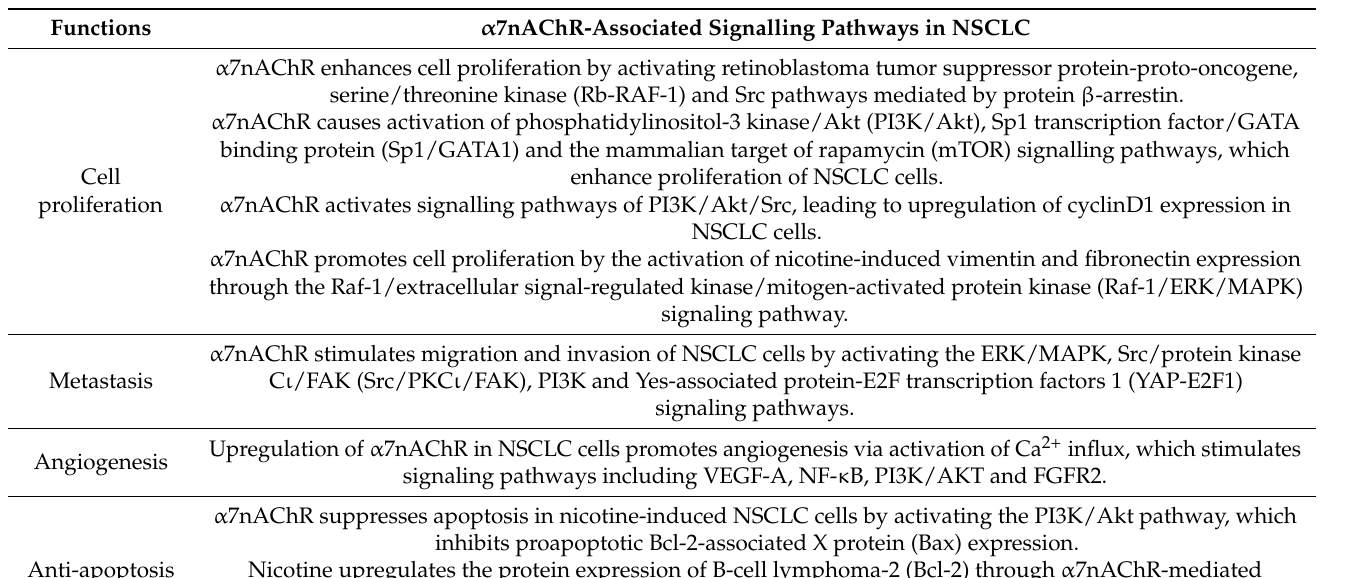
Table 1. Major functions of nicotine/ α 7nAChR in NSCLC